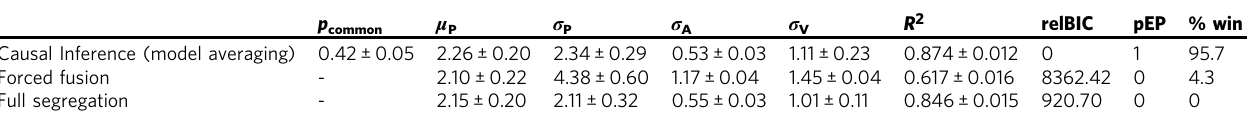
Table 2 Results of the Bayesian model comparison of the Bayesian Causal Inference, the forced-fusion and the full-segregation model